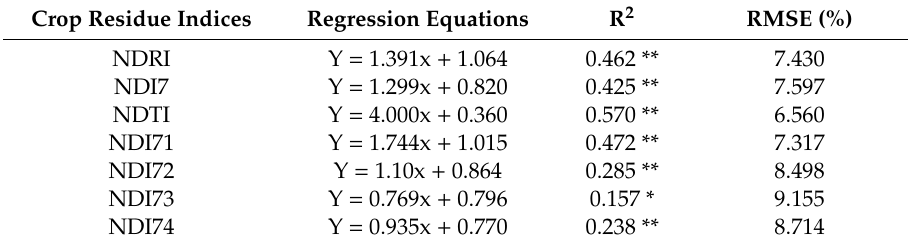
Table 2. The regression relationships between CRC and optical crop residue indices.